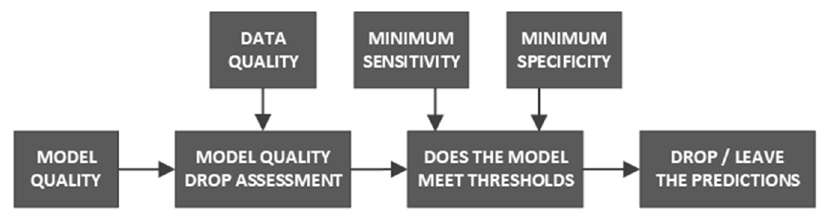
Figure 12. Prediction quality assessment pipeline proposal.